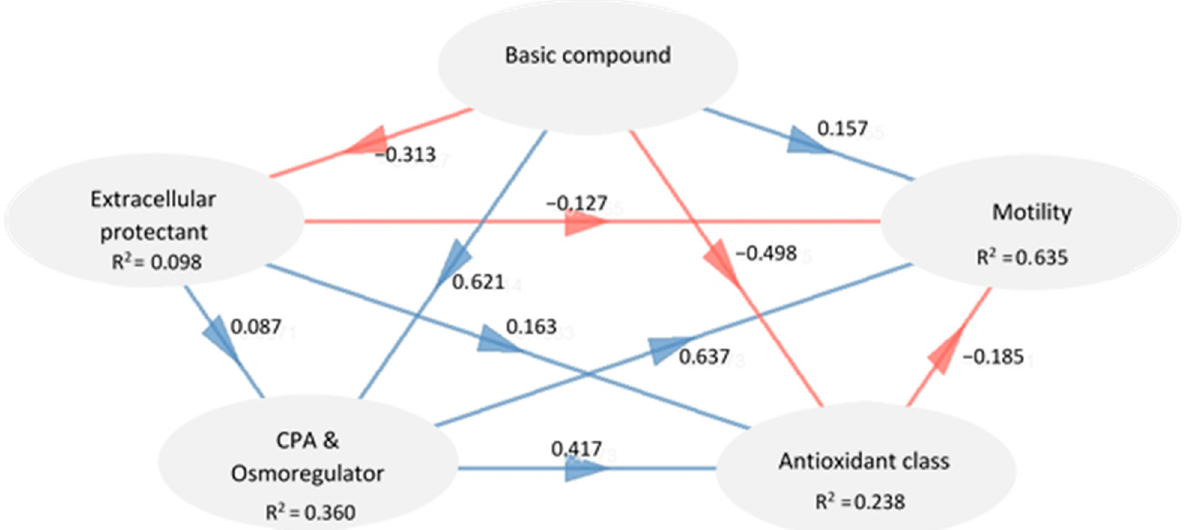
Figure 8. The structural model represents the network of interactions between blocks. Each arrow represents its direct coefficient. Blue and red arrows represent positive and negative coefficients, respectively. Endogenous blocks are also presented with their R 2 coefficient.